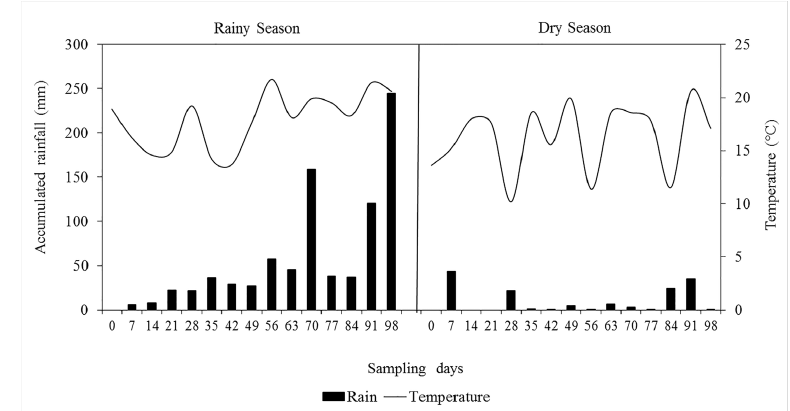
Figure 1. Average daily accumulated rainfall and air temperature during study